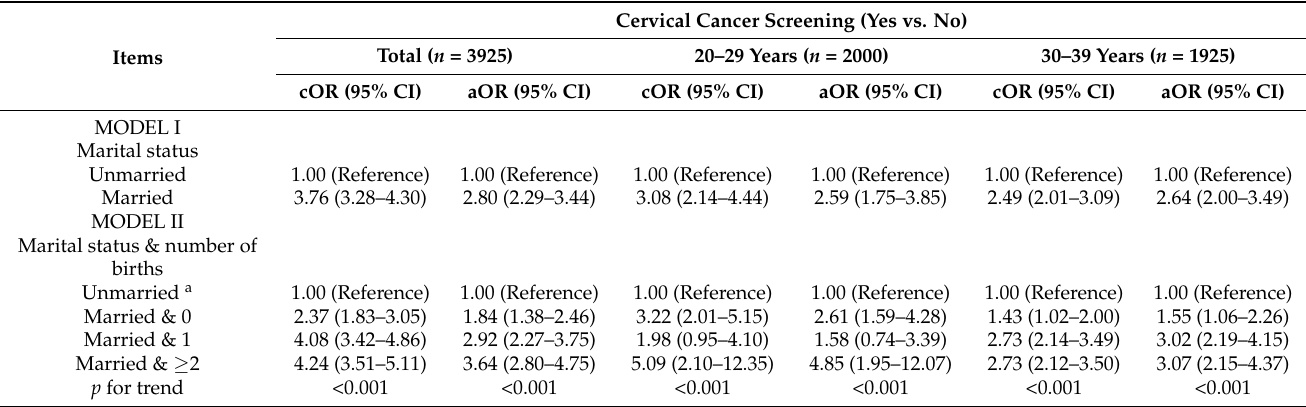
Table 2. Association between marriage-related variables and cervical cancer